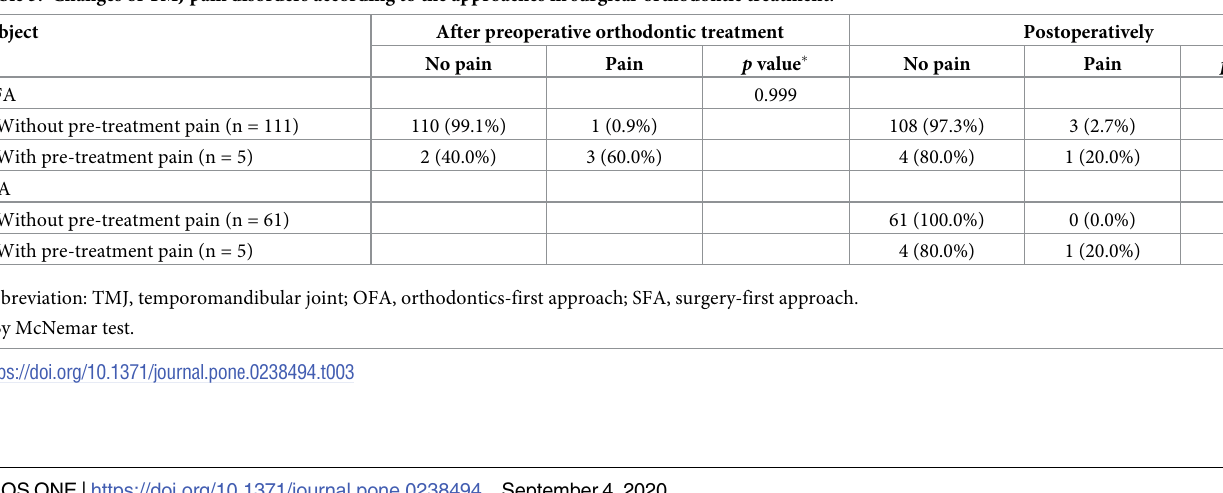
Table 3. Changes of TMJ pain disorders according to the approaches in surgical-orthodontic treatment.